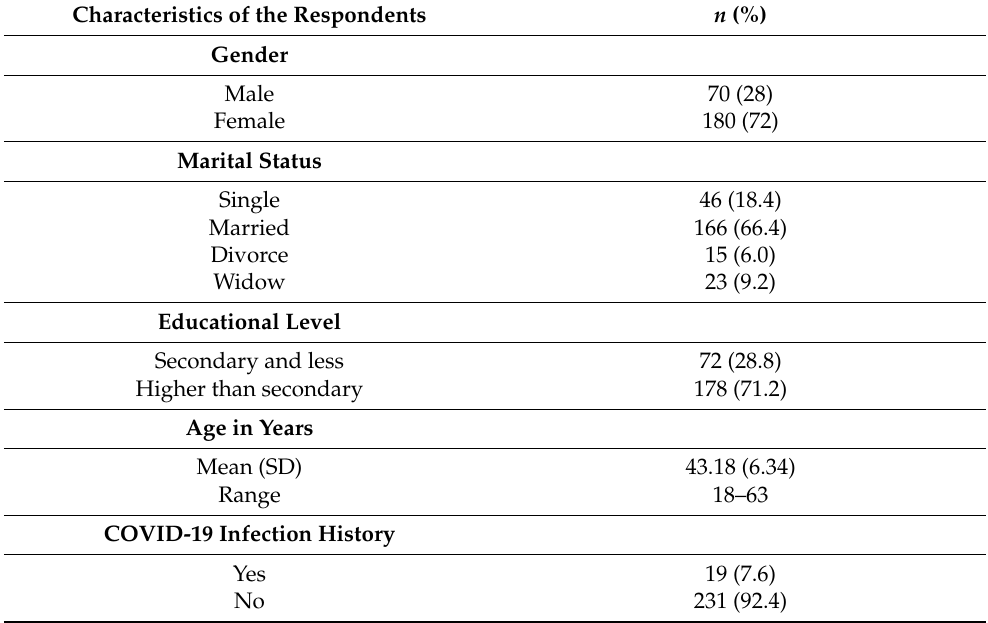
Table 2. Demographic characteristics of the participants ( n =